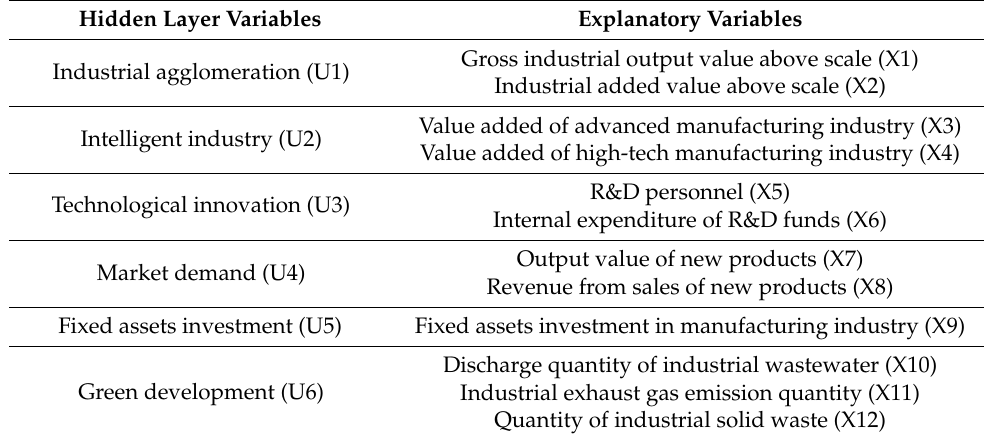
Table 1. The macro factors for